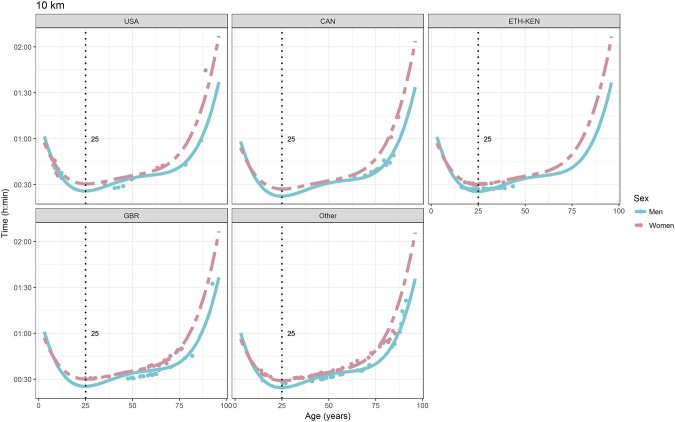
World record in 10 km by sex, age (in years), and country. Points were observations. Curves represented quartic degree polynomial regression. Vertical line with numeric label was the age at peak performance.